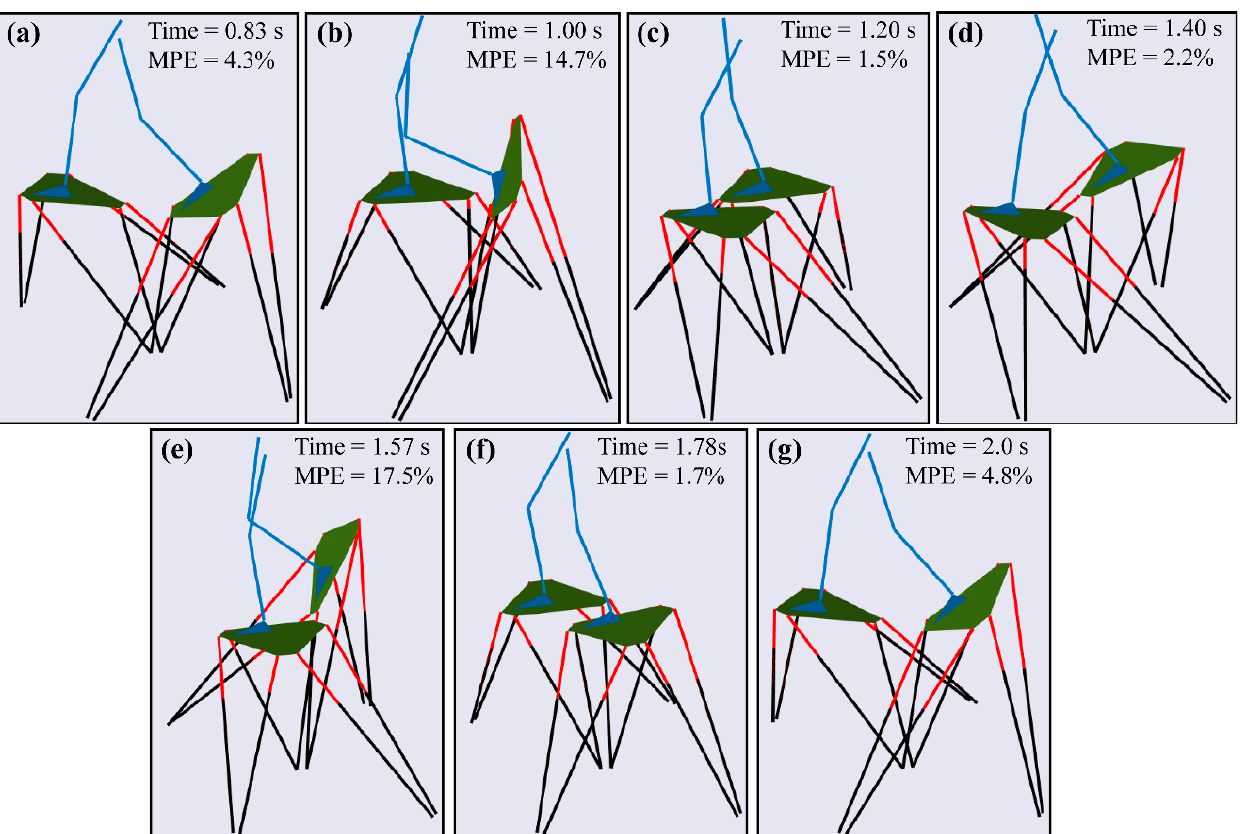
Figure 2. The schematic view of the simulated footplate-based robo-assisted system during the gait cycle. ( a ) left pre-swing, ( b ) left initial-swing, ( c ) left terminal stance, ( d ) left initial contact, ( e ) left mid-stance, ( f ) left terminal stance, and ( g ) left pre-swing. The MPE is presented in each stage. The 1st, 2nd, 3rd, 4th, 5th, and 6th leg forces, as well as the ankle and knee torques, The left horizontal and vertical positions and rotation angle of the top plate, as well were calculated in a complete stride and presented in Figure 4. The oscillation around 1–1.10 s relates to the spatial configuration of the robot at that specific time because the top plate needed to mimic the pattern of foot orientation in the initial swing. Since this orientation turns the top plate into the vertical position, the legs of the Stewart robot reach a limit at their length, which causes such an oscillation at that time. The values of the ankle and knee torques produced by the robo-assisted system are considerably bigger than torques produced during the normal gait [38]. Although the robo-assisted system shows the same kinematics compared to the human gait pattern, their kinetics are significantly different. This difference has something to do with the different functions of actuators in the exoskeleton compared to the human gait. For example, in the robo-assisted system, the movement of the foot is generated by the Stewart platform, while in the human gait pattern, this is produced by the torques of muscles involved in the ankle joint. The leg movement in the Stewart platform is produced by the actuator of the ankle joint, while in the human, it is produced by the torques of muscles involved in the knee joint. Finally, yet importantly, in the Stewart platform, the thigh movement is generated by the actuator of the knee joint, while in the human, it is produced by the muscular torques of the hip joint. These differences can be the reasons why we have such a difference in our data